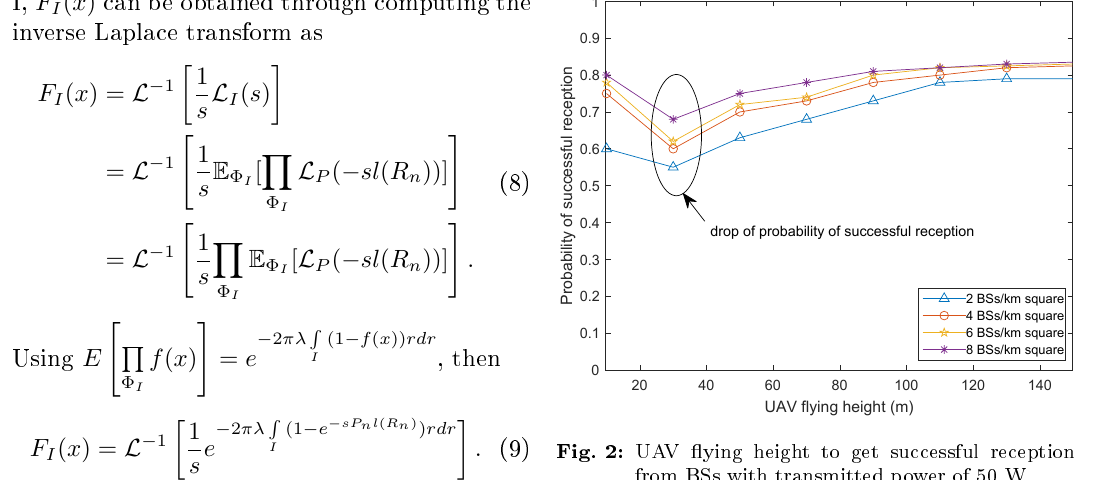
Fig. 2: UAV (cid:29)ying height to get successful reception from BSs with transmitted power of 50 W. been done for some cases that all UAVs op- erate at the same height in order to con(cid:28)rm the numerical results. The parameters used for numerical results and simulation are presented in Table 1. Note that all the parameters for path-loss are from experimental results and are adopted from [16]. The BSs using in the simu- lation are marco BSs with height of 30 m and transmitting power of 50 W (approximately 47 dBm)(Figure 2) and 30 W (approximately 45 dBm). Figure 2 denotes the e(cid:27)ect of UAV (cid:29)ying height on the system performance in term of the probability of successful reception at UAV